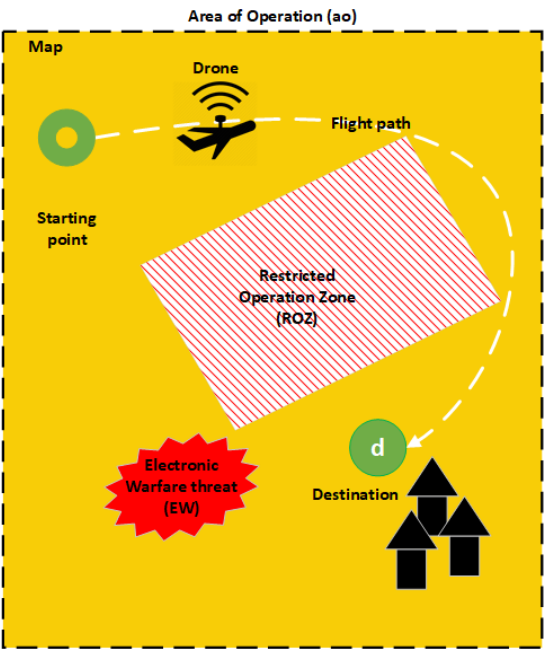
Figure 4. Visualisation